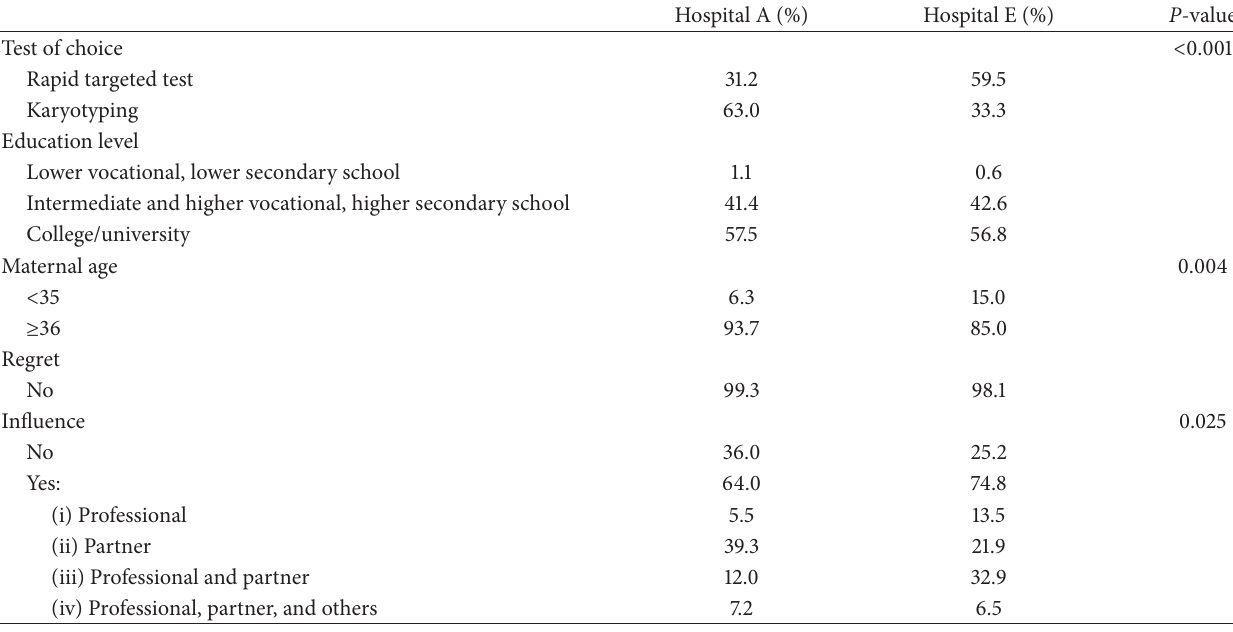
Table 5: Characteristics of the respondents of the two hospitals A and